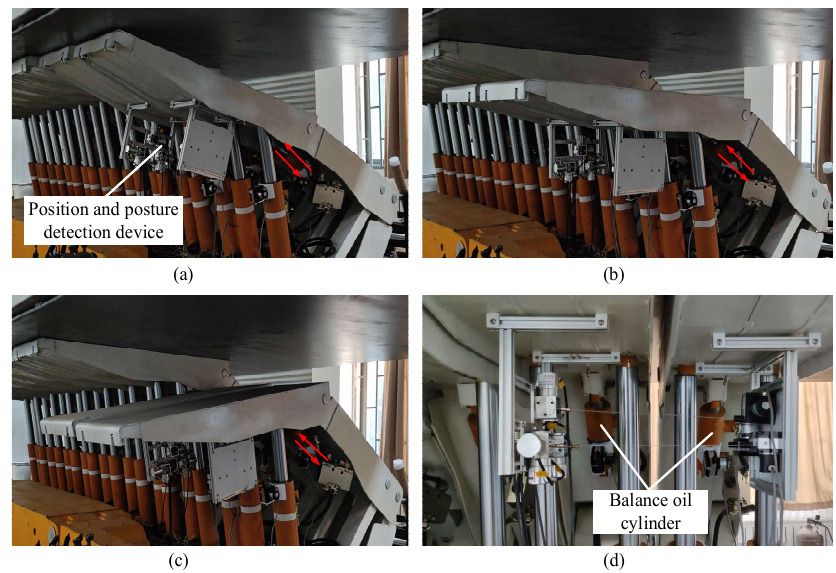
Figure 22. Following motion experiment of the balancing cylinder of hydraulic support. ( a – d ) shows the position of the balancing cylinder and the expansion trajectory The following motion experiment of the moving cylinder: firstly, set the column and